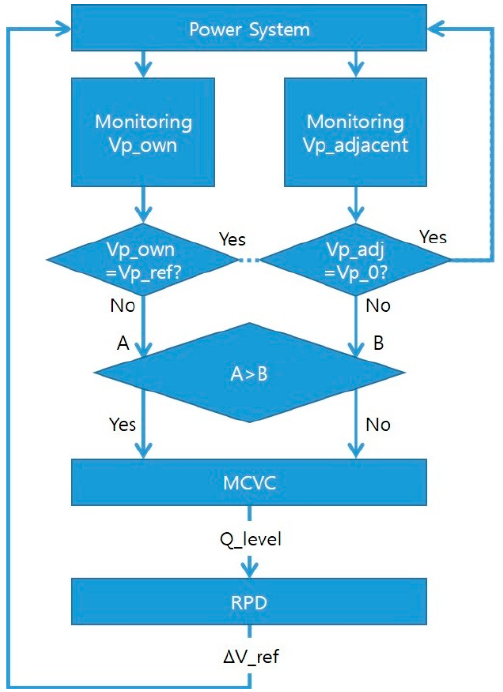
Figure 8. Control scheme of the MCVC.